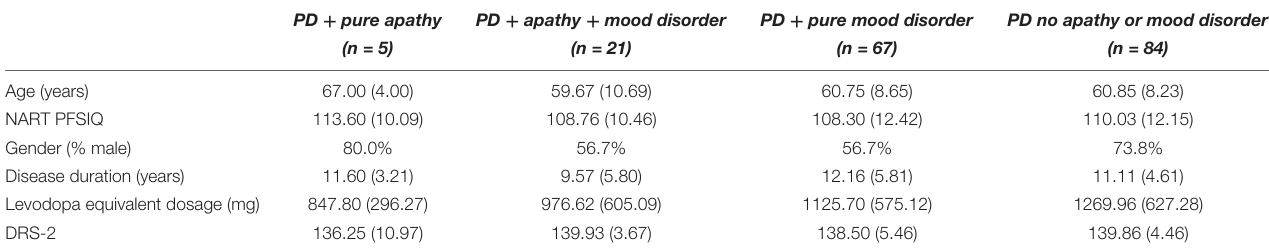
TABLE 2 | Demographics of PD patient groups [mean